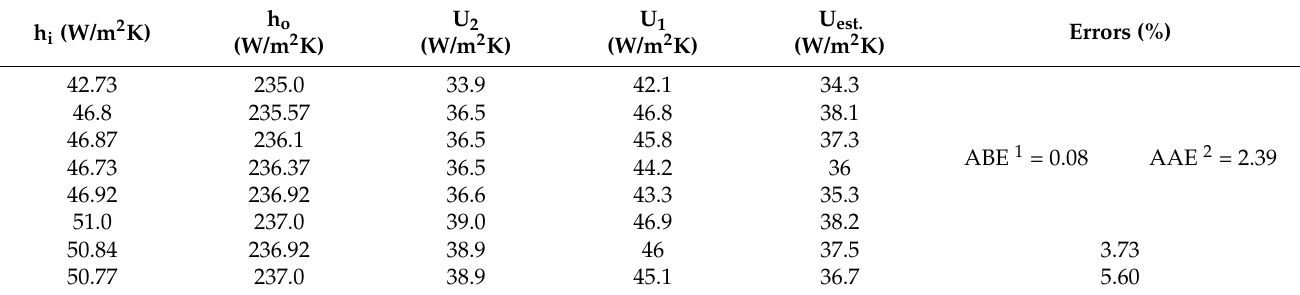
Table 3. Estimation of overall heat transfer coefficients (U 2 ) using the second